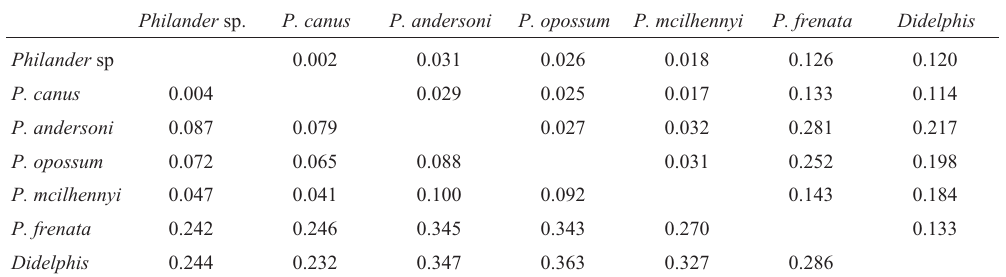
Table 2 - Genetic distances estimated according to Tamura and Nei (1993) modeled by a gamma distribution with alpha parameter equal to 0.23 (lower diagonal). Standard errors estimated using bootstrap (upper